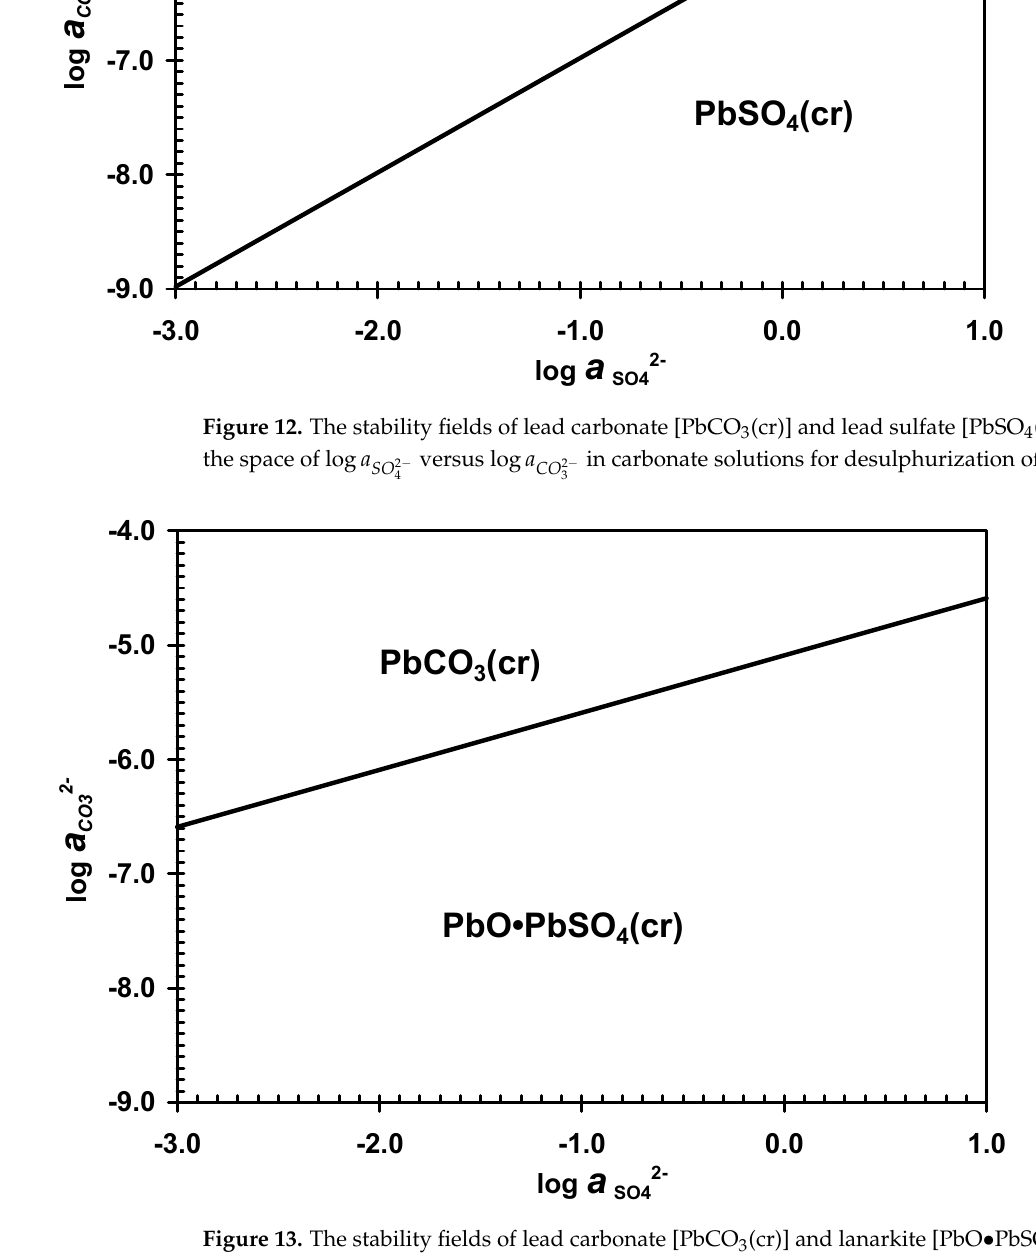
Figure 13. The stability fields of lead carbonate [PbCO 3 (cr)] and lanarkite [PbO • PbSO 4 (cr)] at 25 ◦ C in the space of log a versus log a at pH = 10 and water activity of 1.0 in carbonate solutions SO 2 − 4 CO 2 − 3 for desulphurization of lead pastes.